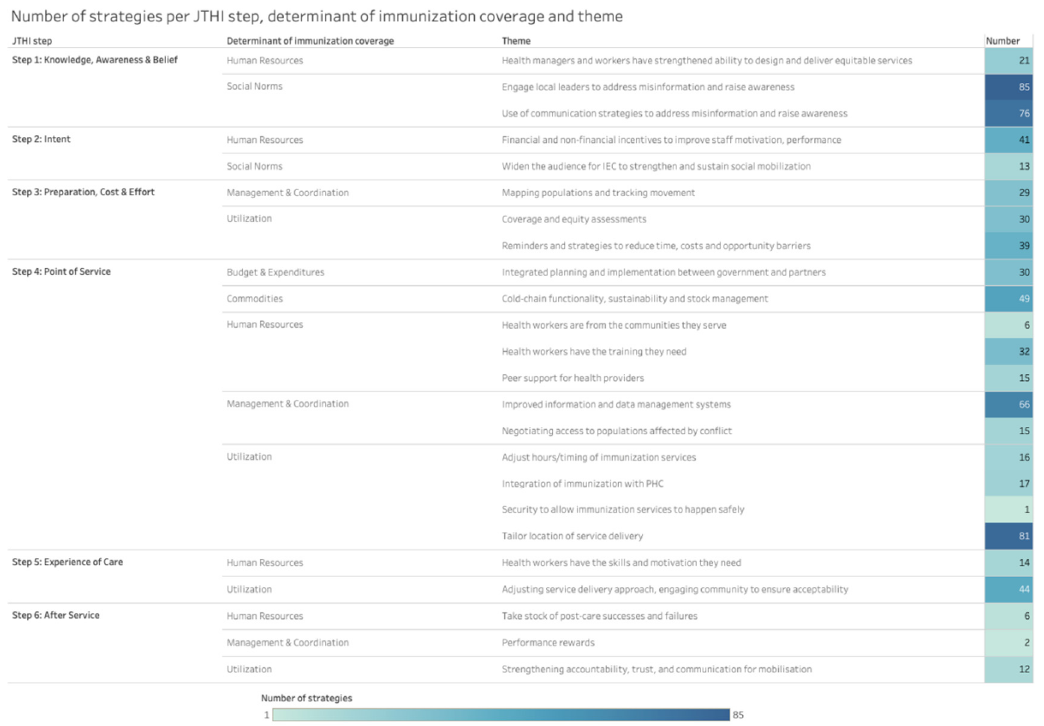
Figure 3. Number of strategies per JTHI step, determinant of immunization coverage and theme.